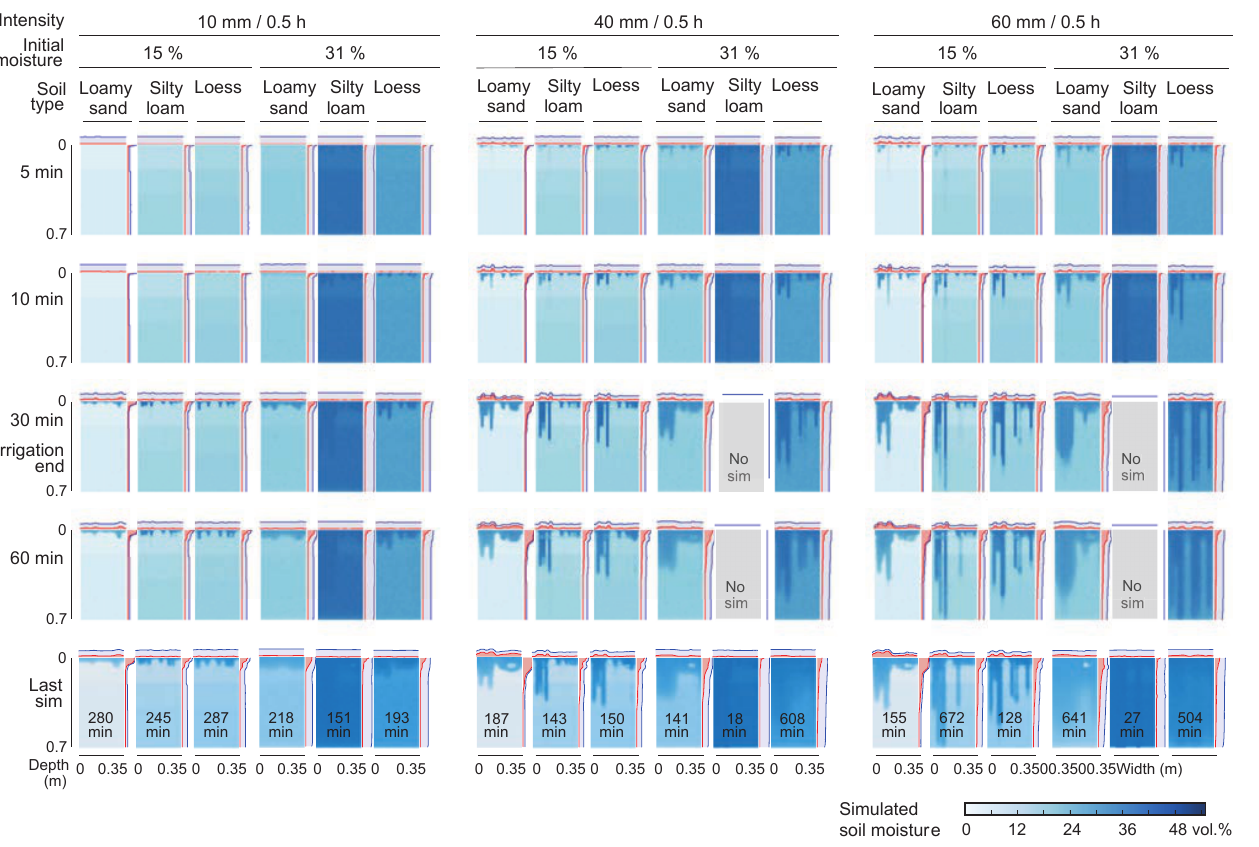
Figure 6. Table of simulated soil moisture dynamics in generic application tests for loess. Marginal plots give the distribution of all particles (blue) and newly infiltrated particles